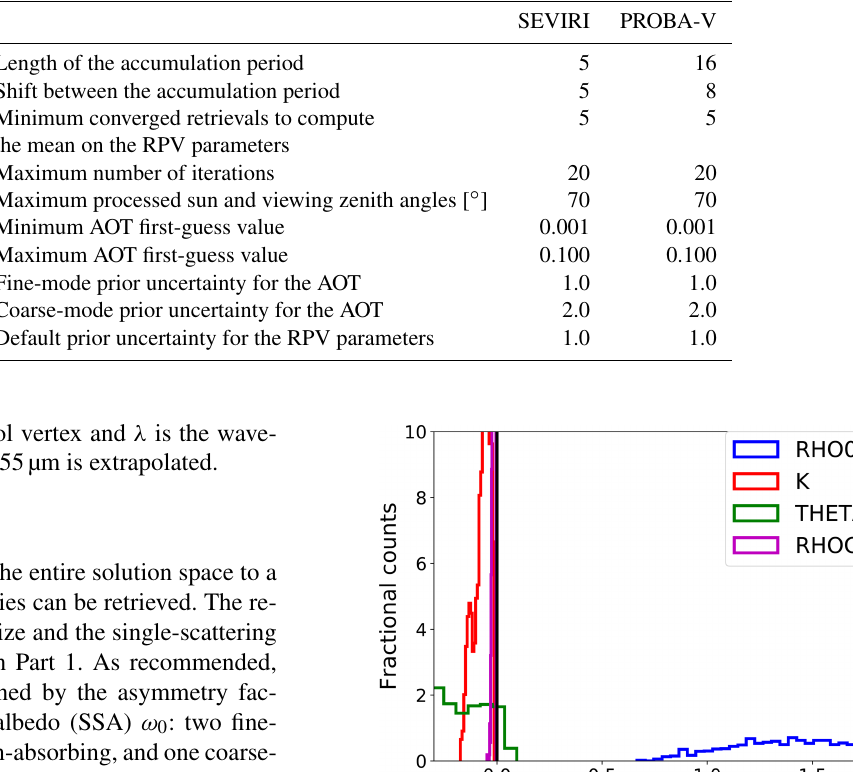
Table 7. CISAR set-up parameters.